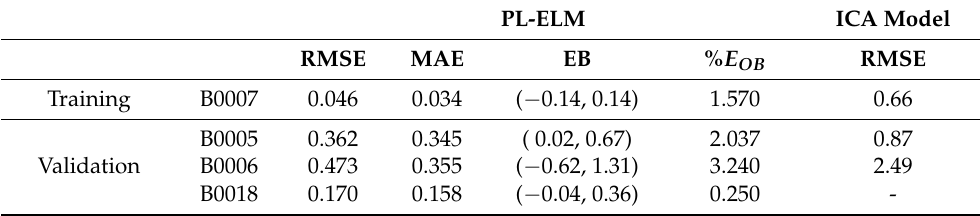
Table 2. SOH estimation performance comparison between PL-ELM and incremental capacity analysis (ICA) model in training and validation. The error bound (EB) and out of bound error (% E OB ) information are also provided.